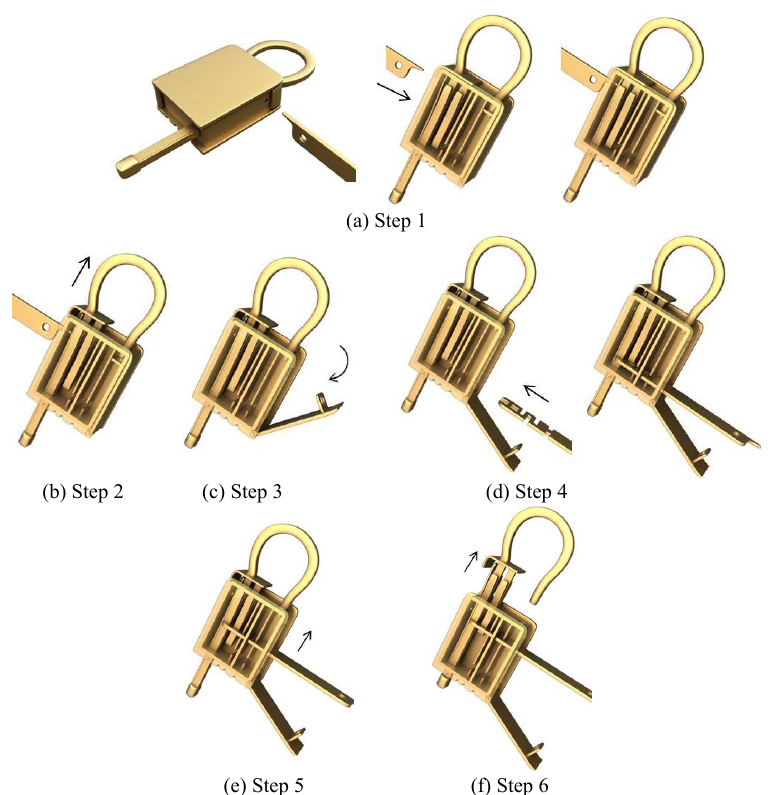
Figure 8. Animation of padlock with a poke